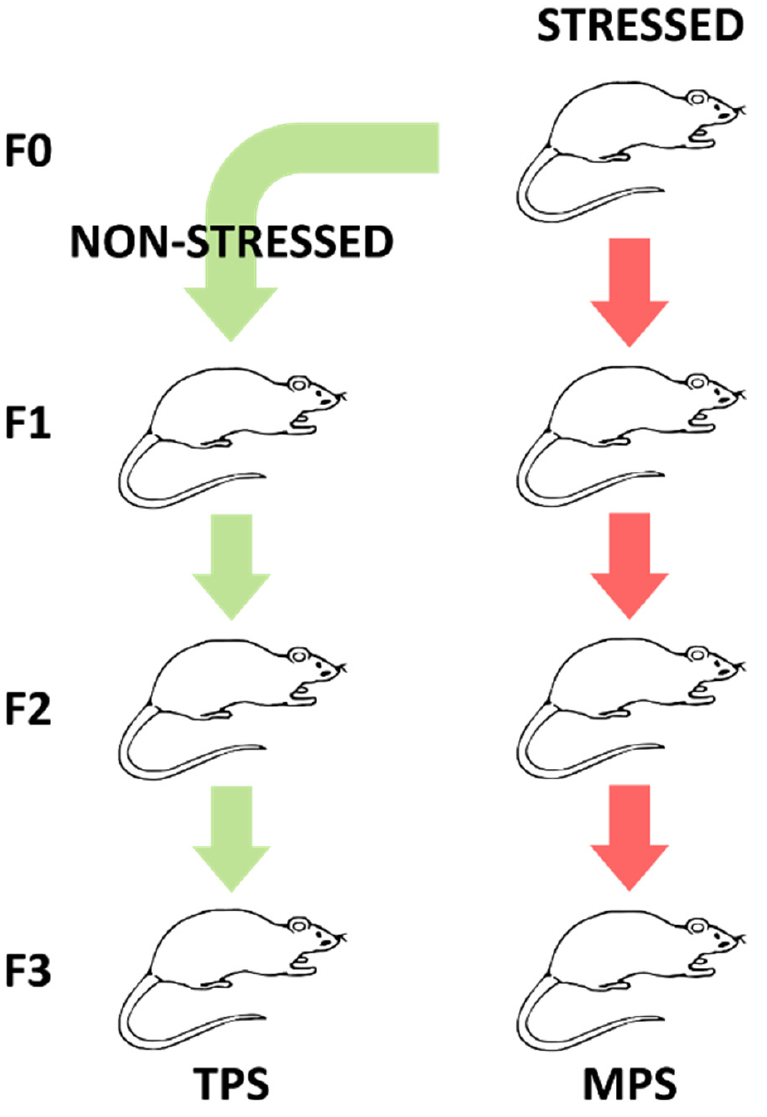
Figure 5. Illustration summarizing the experimental design generating lineages of transgenerational prenatal stress (TPS) and multigenerational prenatal stress (MPS) through filial generation zero (F0) to F3.